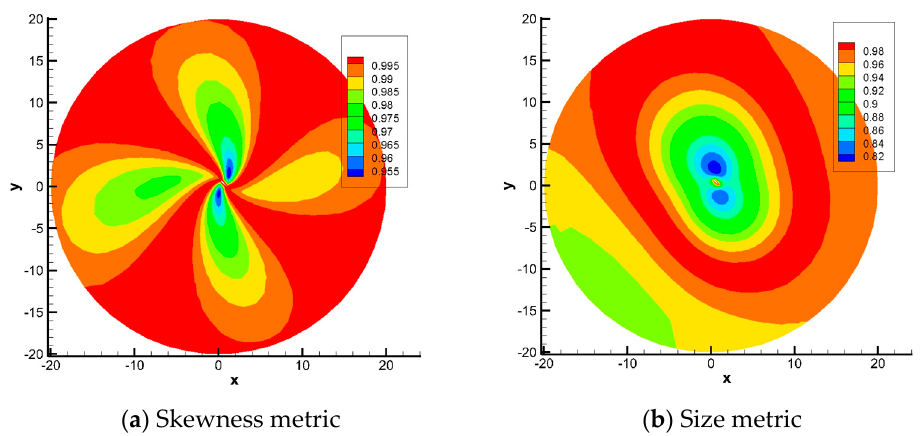
Figure 10. Mapping-based metrics of test case 2.